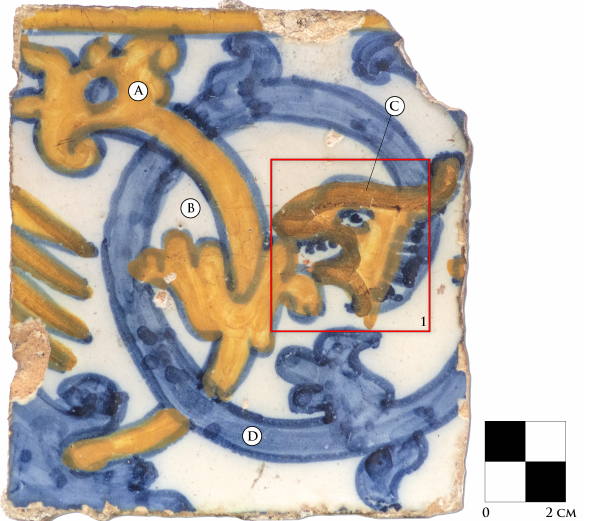
Figure 1. Sample and Macro-X-Ray Fluorescence (MA-XRF) scanned area (1). The colours identified are: yellow ( A ), white ( B ), orange ( C ) and blue ( D ).